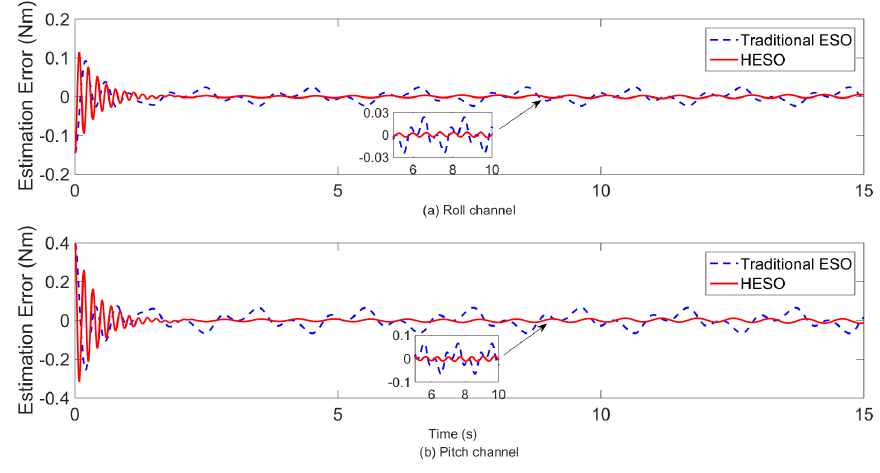
Figure 5. Estimation results comparison of harmonic extended state observer (HESO) and traditional extended state observer (ESO) in attitude stabilization.